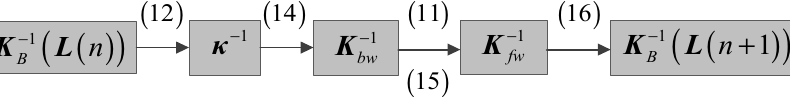
Figure 3. Recursive update process of the kernel Gram matrix inversion.